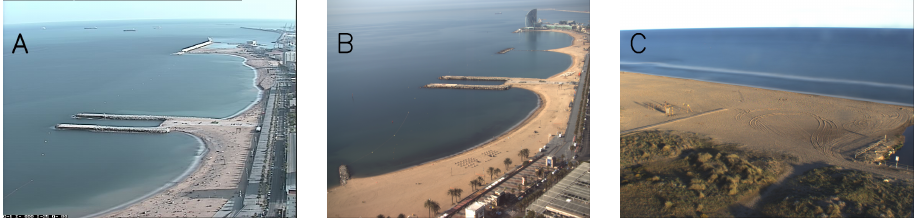
Figure 6. Images from BCN1 (( A ), 768 × 576pixels 2 ), BCN2 (( B ), 2452 × 2056pixels 2 ) and CFA1 (( C ), 1280 × 960pixels 2 ) video monitoring stations (coo.icm.csic.es (accessed on 15 July 2021)).